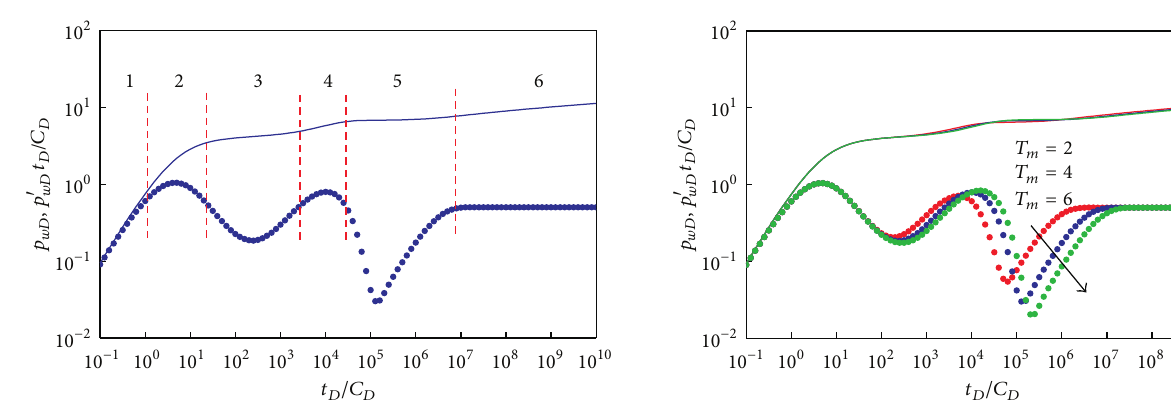
= 10 m, 𝑑 = 0.05 m, 𝐷 = 1.5 , 0 0 𝑓 = 0.0001 , ℎ = 10 m, 𝐶 = 2.2×10 −5 MPa −1 , 𝐷𝑒 𝑚𝑡